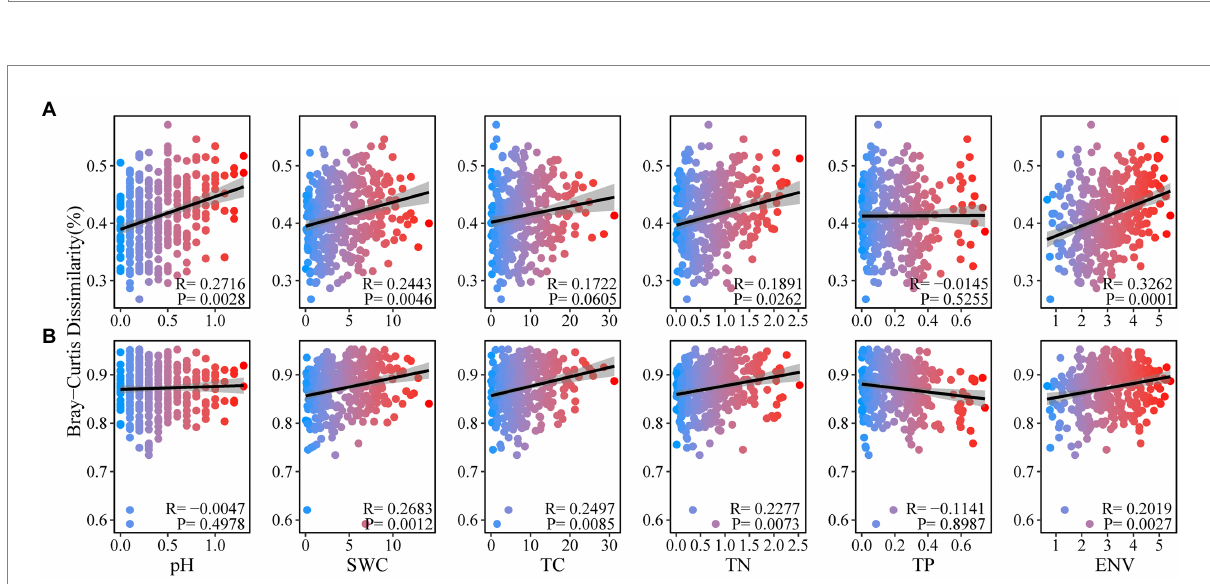
FIGURE 4 Distance–decay relationship for soil physicochemical properties with soil bacterial (A) , and fungal (B) , communities under forest stand differences.